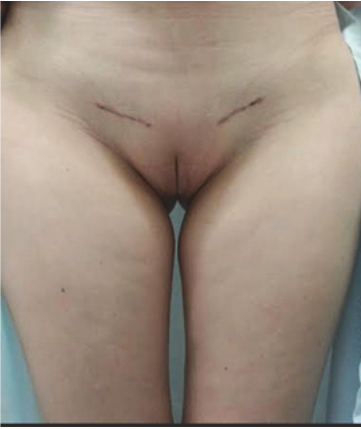
Figure 1: Surgical outcome following bilateral incisions for gonadectomy.